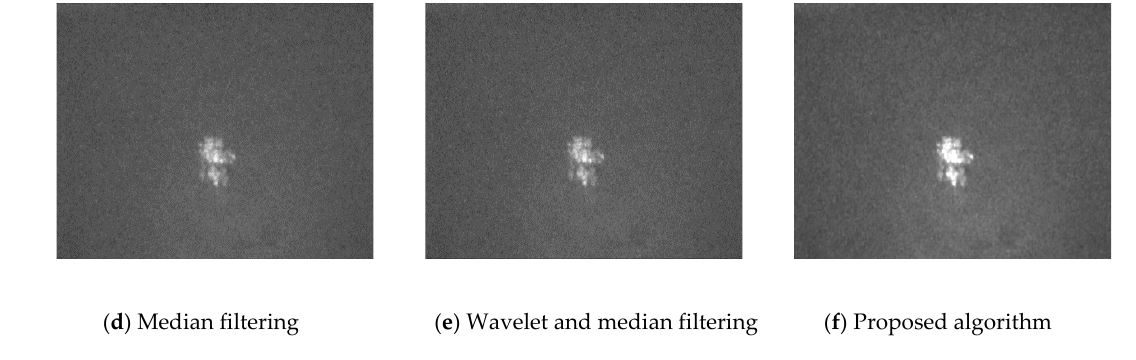
Figure 15. ( a – f ) Reduction e ff ect of di ff erent algorithms. Table 4. Comparison of performance indicators of di ff erent